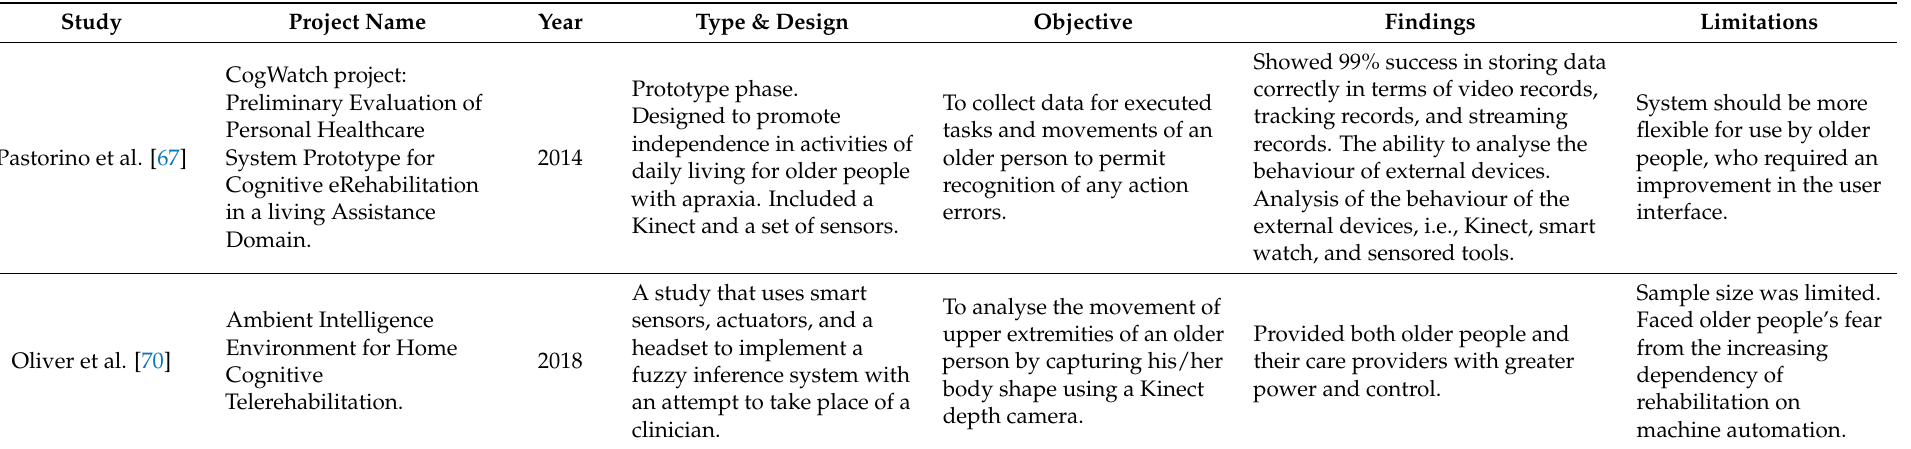
Table 6. ICT solutions for assistive living of older adults that encountered a